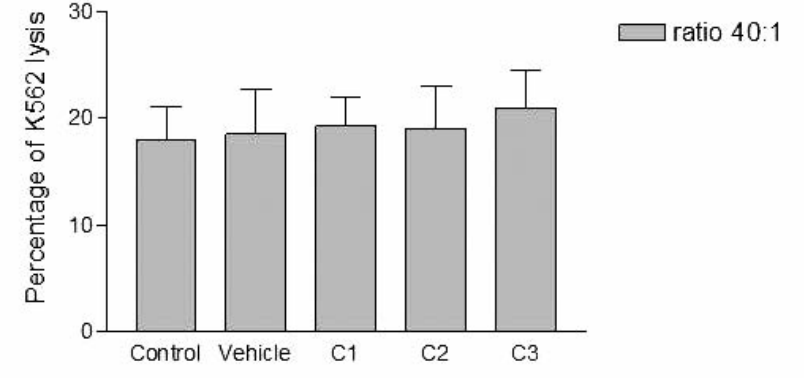
Figure 4. Effects of various concentrations of PCDD/Fs mixture on the E. andrei NK-like cell activity to lyse the human tumor cells (K562). The effectors were washed of the PCDD/Fs before contact with K562.